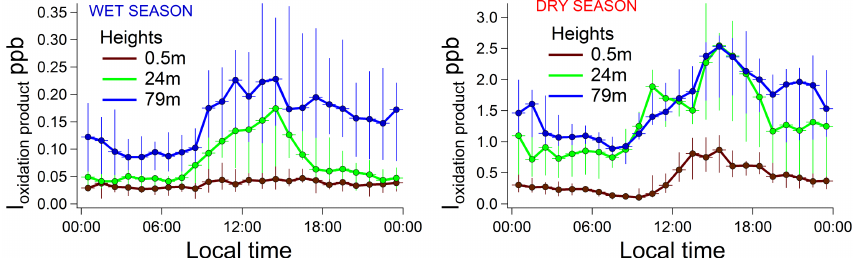
Figure 6. Diurnal hourly median isoprene oxidation product (I oxidationproducts ) mixing ratios during the wet season (left) and the dry season (right) for different heights. Range bars represent the 75 and the 25% percentiles.